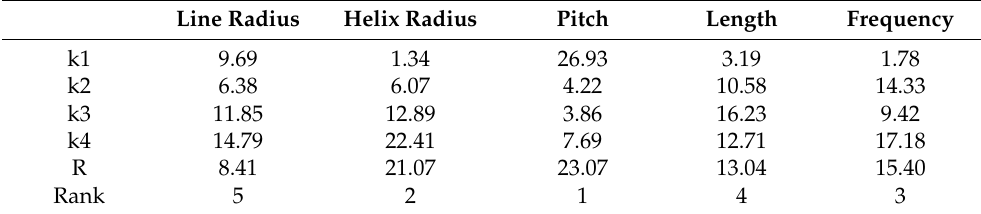
Table 4. The main effect of five parameters acting on the torque.